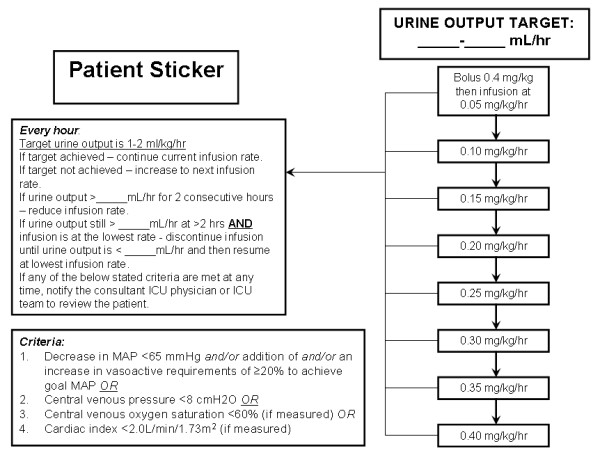
Overview of the SPARK study drug infusion algorithm.